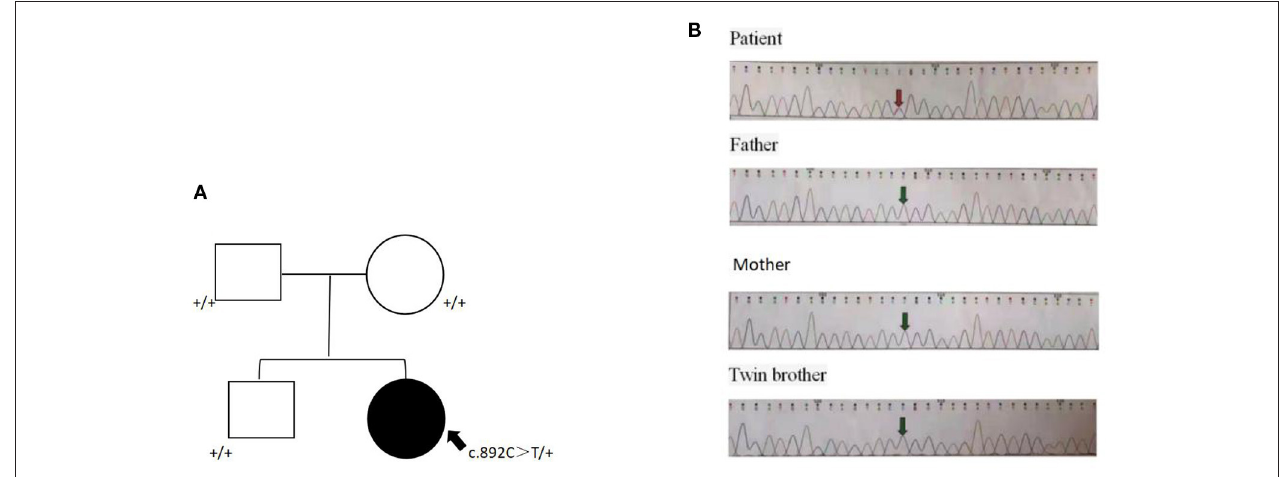
FIGURE 2 | De novo c.892C > T (p.Arg298Trp) missense change in NACC1. (A) Pedigree of the family. A heterozygous missense was detected in the proband but not the parents. (B) Sanger validation of the missense variant in the proband and parents. Arrow indicates the site of the variant.